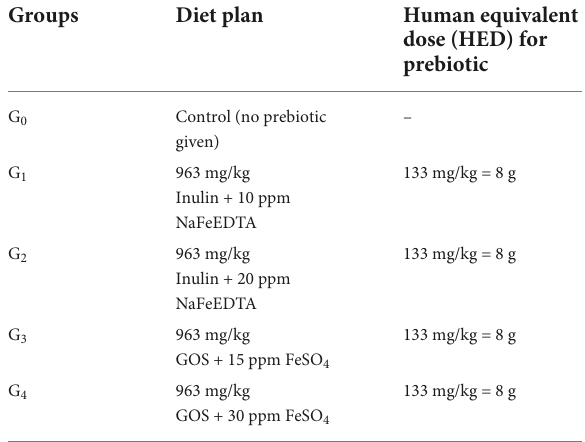
TABLE 1 Treatment plan (iron fortificants and prebiotics based diet).